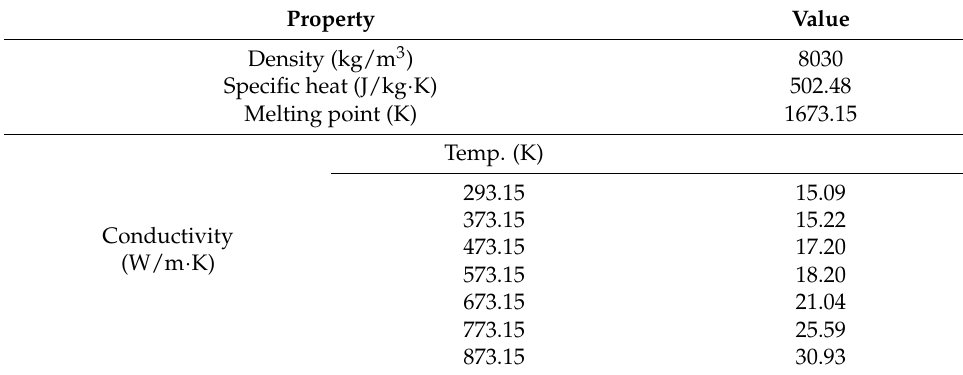
Figure 14. Schematic of the diffuser cooling channel system. Table 3. Properties of solid STS